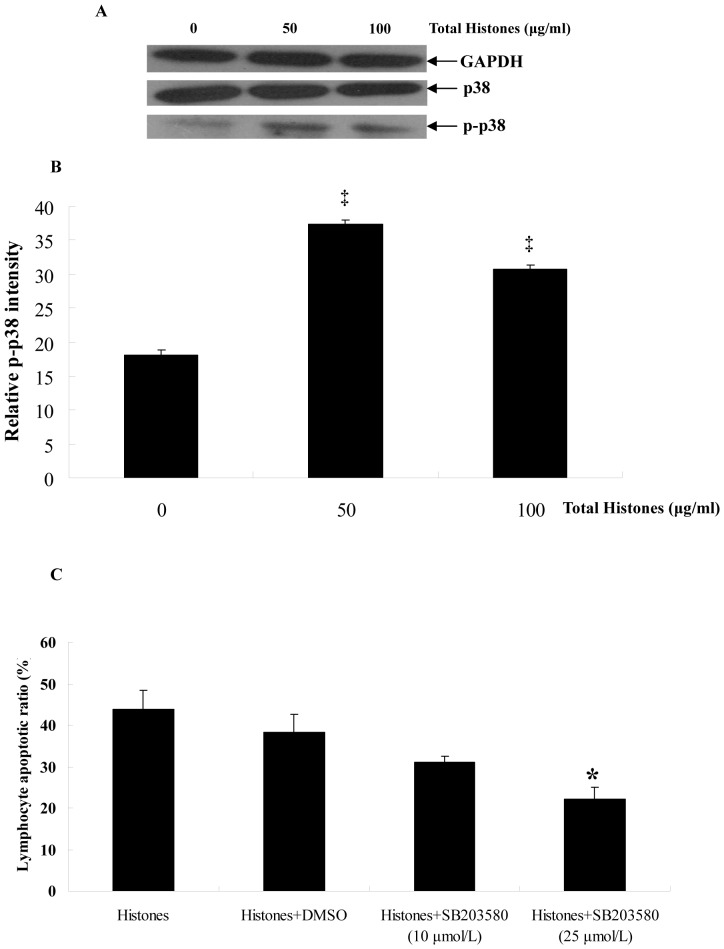
Inhibition of p38 phosphorylation blocked lymphocyte apoptosis induced by histones.A. Western blotting results of P38 phosphorylation. Lymphocytes were harvested after histones treatment for 2± SD (n = 3). ‡P<0.05, as compared with 0 µg/ml group. C. Human lymphocytes were exposed to 100 µg/ml histones with DMSO, 10 and 25 µmol/L SB203580. Lymphocyes were harvested 2 h after treatment for apoptosis detection by flow-cytometry. Values are presented as means ± SD (n = 3). *P<0.05, as compared with control.